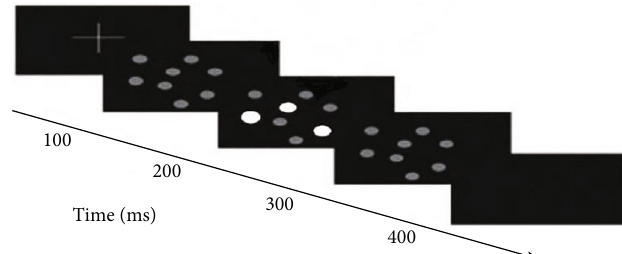
Figure 2: MOT task experimental